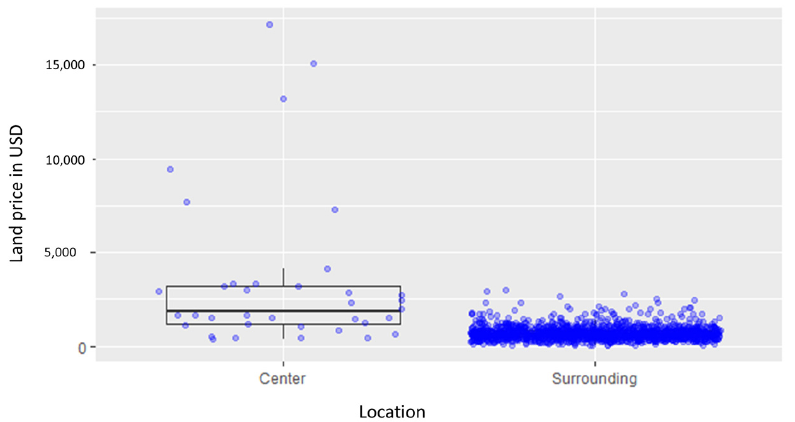
Figure 6. Actual urban land lease prices per m 2 in USD by categorized locations (the center and surrounding). The center is within the CBD, while the surrounding is beyond the 5 km radius.